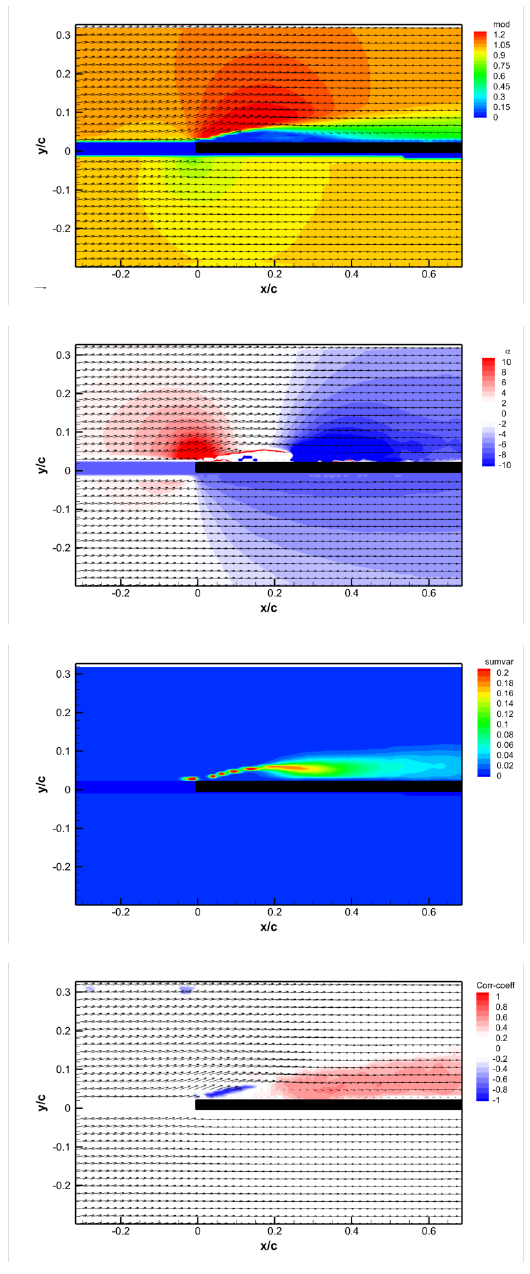
Fig. 3. Mean velocity, down-wash angle, TKE and correlation coefficient distributions, the area of separation bubble